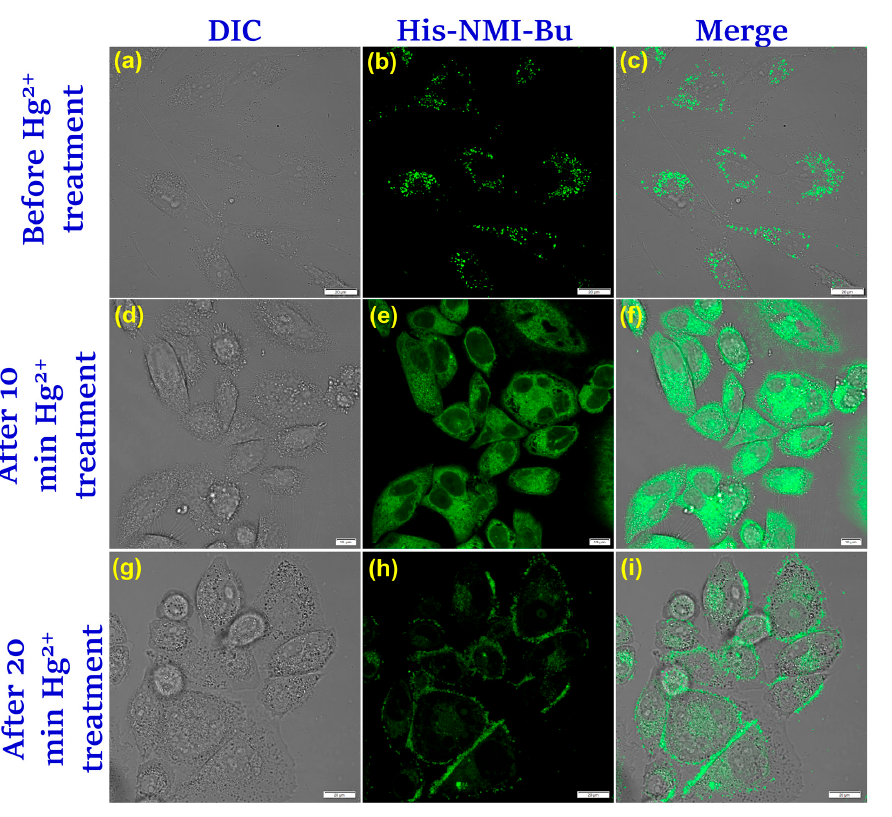
Figure 7 . CLSM images of live BHK-21 cells showing the intracellular sensing response of Hg 2+ . Left panel ( a , d , g ) shows the DIC images; middle panel ( b , e , h ) shows FITC channel images ( λ ex = 488 nm, λ em = 500–540 nm) of cells stained with 5 µM His-NMI-Bu ; right panel ( c , f , i ) shows the corresponding merge images. After dye staining, the cells were treated with 10 µM HgCl 2 and imaged after 10 min and 20 min ( d – i ). The gradual decrease in fluorescence intensity confirms the detection of Hg 2+ inside the lysosomal compartment.